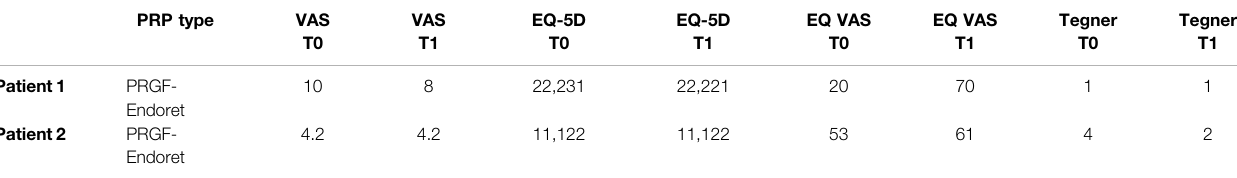
TABLE 1 | Results of VAS for pain, EQ-5D, Tegner Scale at T0 (before injection) and T1 (two months after the fi rst PRP injection).